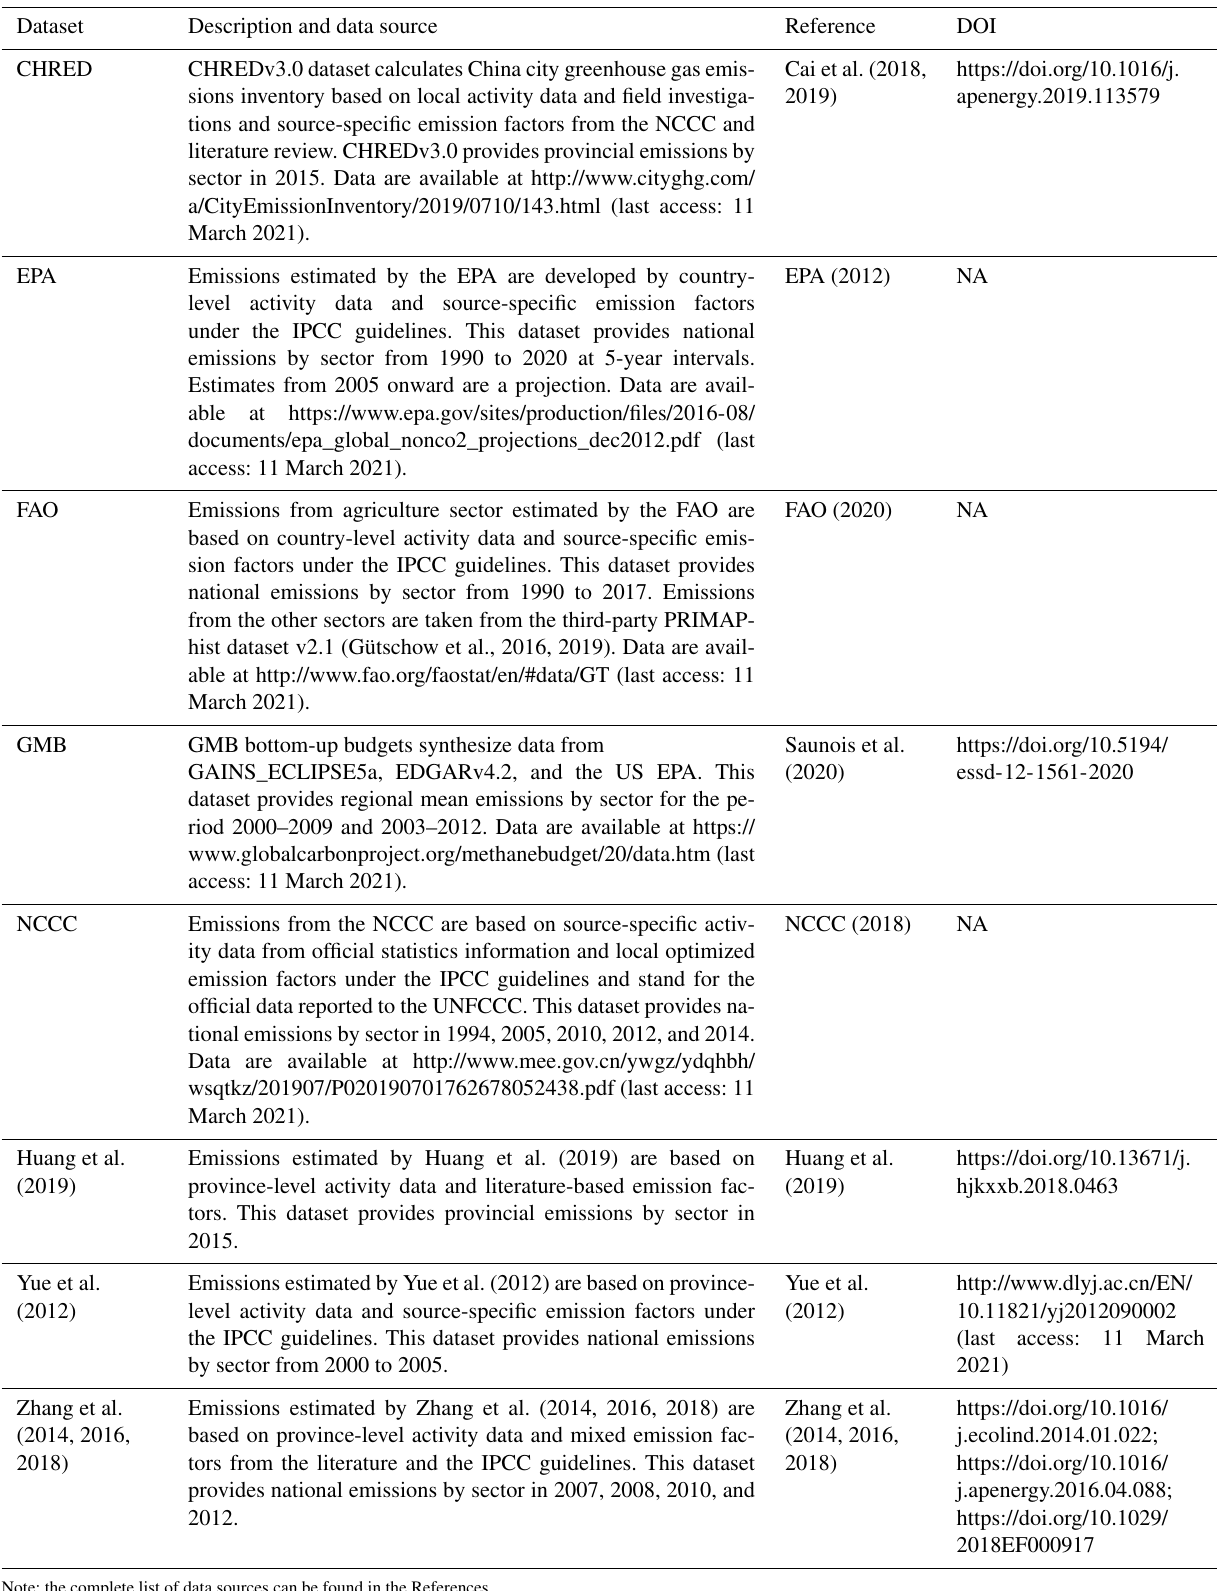
Table 2. A list of tabular data used in the comparison.